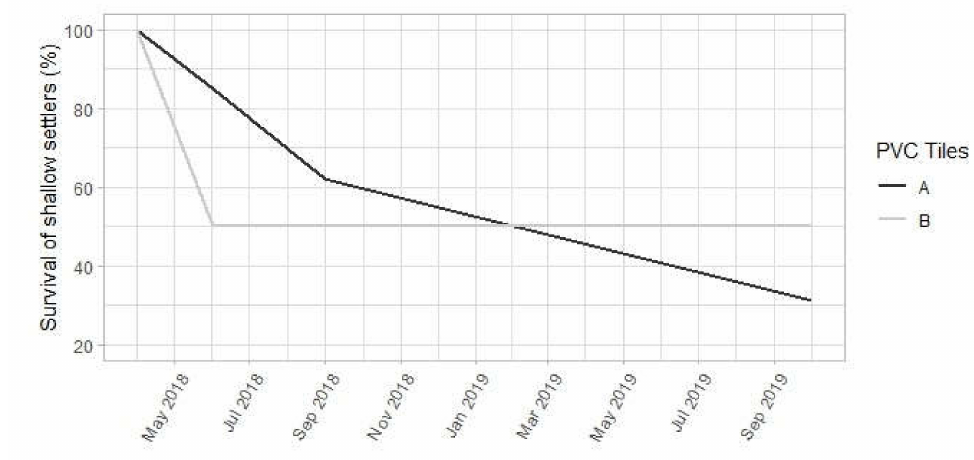
Figure 8. Survival (expressed in percentage) of C. rubrum shallow settlers on PVC tiles from the beginning of the experiment in deep water to October 2019 at Portofino